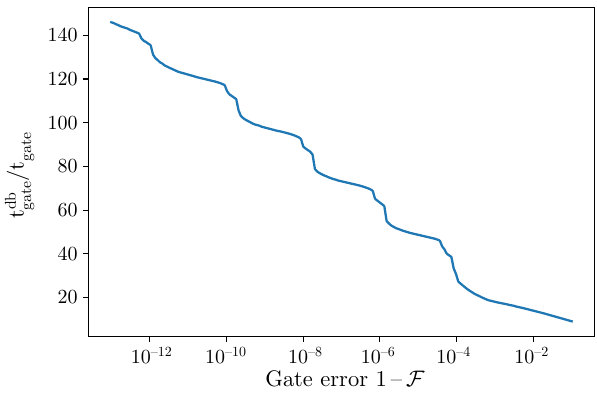
/ t FIG. 7. The speedup factor t db gate by which the gate time gate of our CNOT implementation is reduced as compared with that of a dipole-blockade scheme carried out with Gaussian pulses (assuming that the dipolar interaction is smaller than the hyper- fine splitting and the largest achievable Rabi frequencies). The speedup increases logarithmically with the maximally admissible gate error 1 − F that we assume to be given by the probabil- ity of a nonresonant excitation (rather than by the decoherence time of the qubits). The oscillatory behavior traces back to Rabi oscillations in the unwanted transition